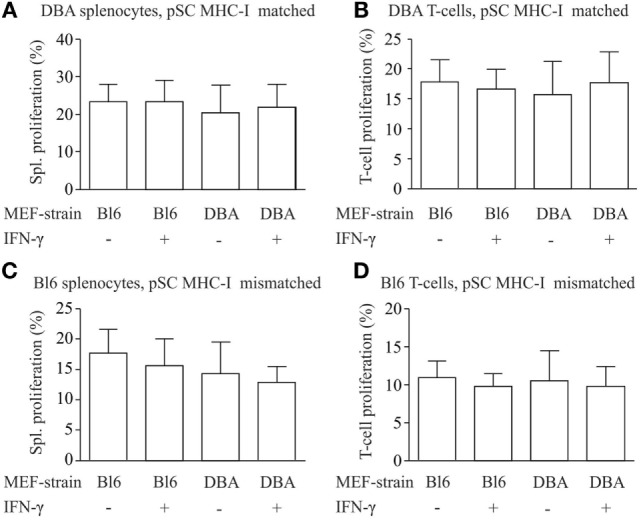
Analysis of immunostimulatory capacity of parthenogenetic stem cell (pSC)-EHM generated from major histocompatibility complex (MHC)-matched or -mismatched pSC-derived cardiomyocytes and murine embryonic fibroblasts. Analysis of proliferation of splenocytes (A,C) and T-cells (B,D) after co-culture with engineered heart muscles (EHMs) containing MHC-matched (A,B) or -mismatched (C,D) pSC-derived cardiomyocytes and murine embryonic fibroblasts in presence or absence of IFN-γ. Spl., Splenocytes; Bl6, C57Bl/6J; DBA, DBA/2J (n = 3/group); MEF, murine embryonic fibroblasts.